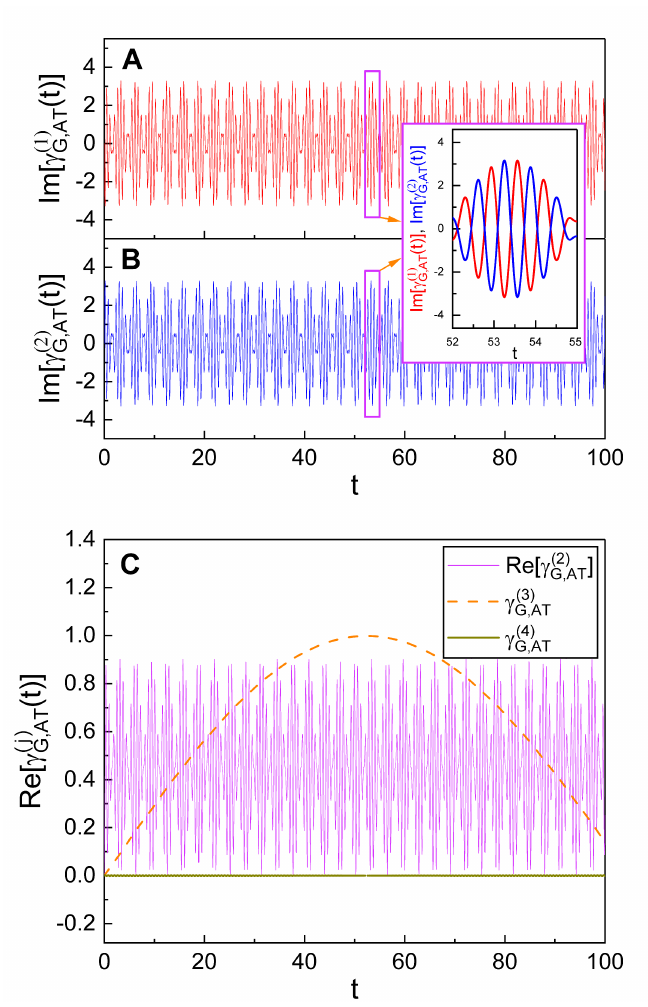
( j ) ( t ) . ( t ) of the added geometric phase γ Figure 5. Temporal evolutions of the components γ G ,AT G ,AT ( 1 ) ( t )] and Im [ γ ( 2 ) ( t )] are given in ( A , B ), respectively, whereas all real parts Imaginary parts Im [ γ G ,AT G ,AT ( j ) ( t )] with j = 1 (red curve) and are given in ( C ). The inset given between ( A , B ) is a graphic of Im [ γ G ,AT j = 2 (blue curve), which is enlarged along t -axis within 52 ≤ t ≤ 55. We used q 0 = 4, while the same values of Figure 4C were used for all other